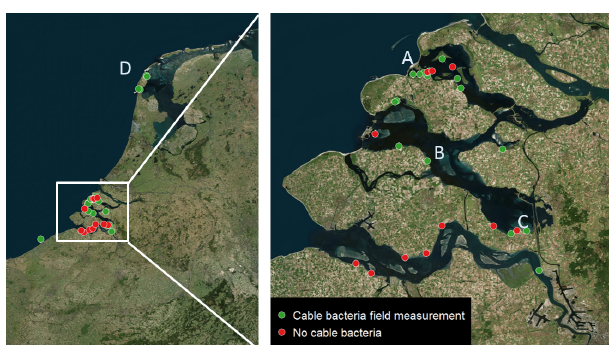
Figure 4. Field site locations examined for cable bacteria activ- ity within a close range to the home laboratory (Belgium and the Netherlands). Green markers indicate locations where cable bacte- ria activity was found. Red markers indicate locations where cable bacteria activity was not detected. The letters A–D indicate the lo- cations of the sites detailed in Fig.